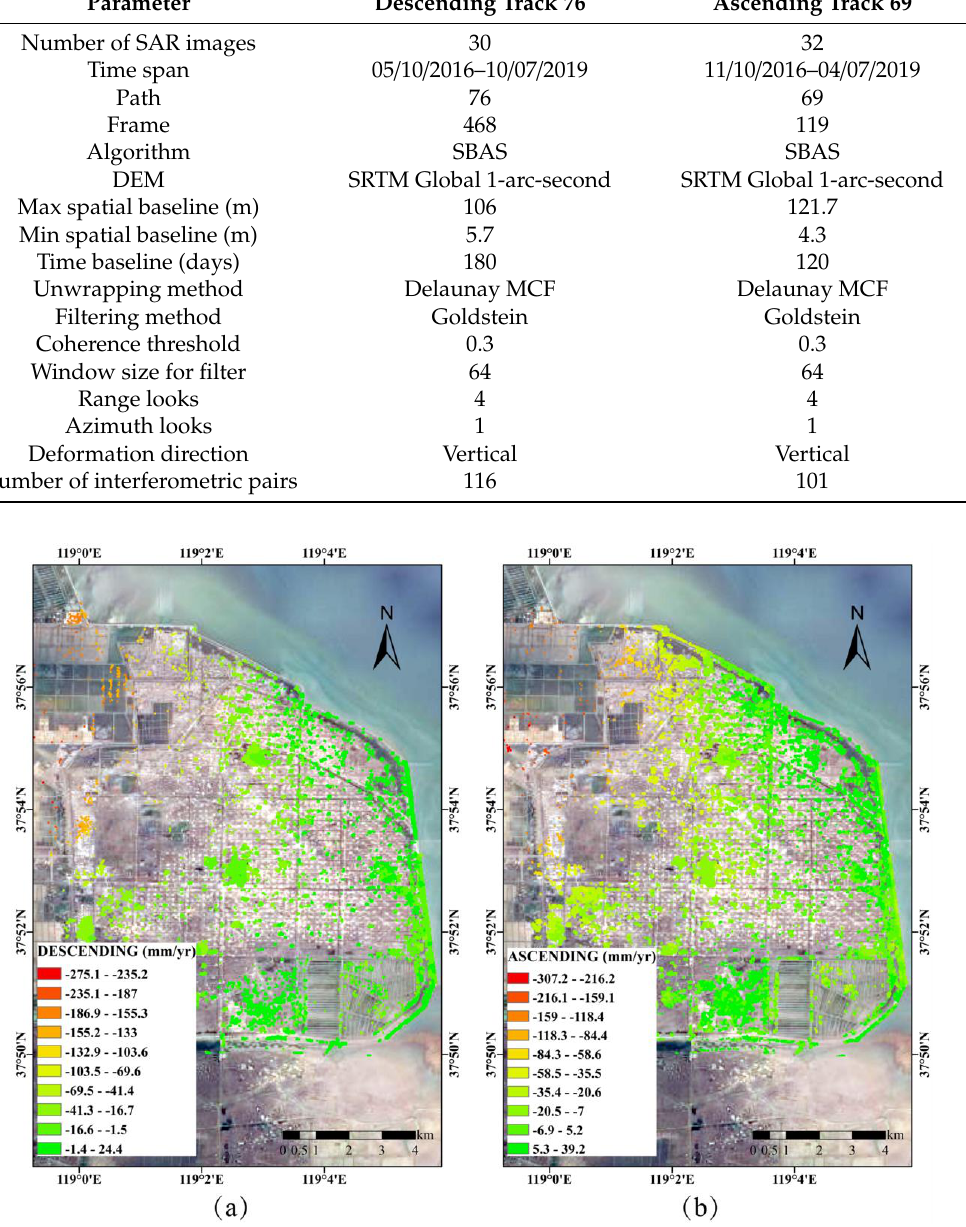
Figure 12. Vertical deformation rate maps estimated by Sentinel-1 SBAS InSAR: ( a ) descending track deformation rate map from the Sentinel-1B images; ( b ) ascending track deformation rate map from the Sentinel-1A images. The base maps are taken from Google Earth.